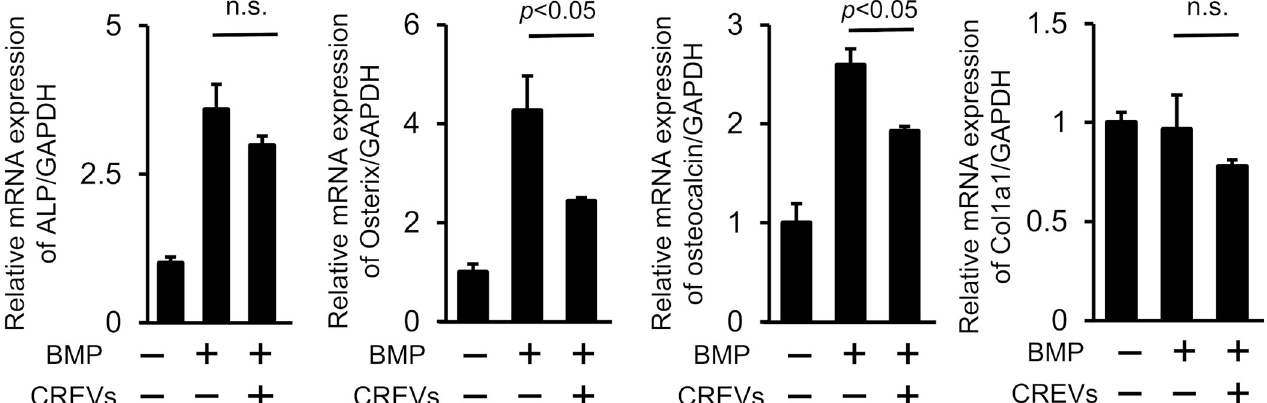
Fig 5. Effects of CREVs on the osteoblastic differentiation of mouse mesenchymal ST2 cells. The mRNA expression of osteogenic markers in ST2 cells cultured with or without 200 ng/mL BMP-2 and/or 4 μ g/mL CREVs for 72 h. Results are expressed relative to Gapdh mRNA levels and are shown as the means ± SEM of 4 independent experiments. Statistical analyses were performed using a one-way ANOVA followed by the Tukey–Kramer post hoc test.